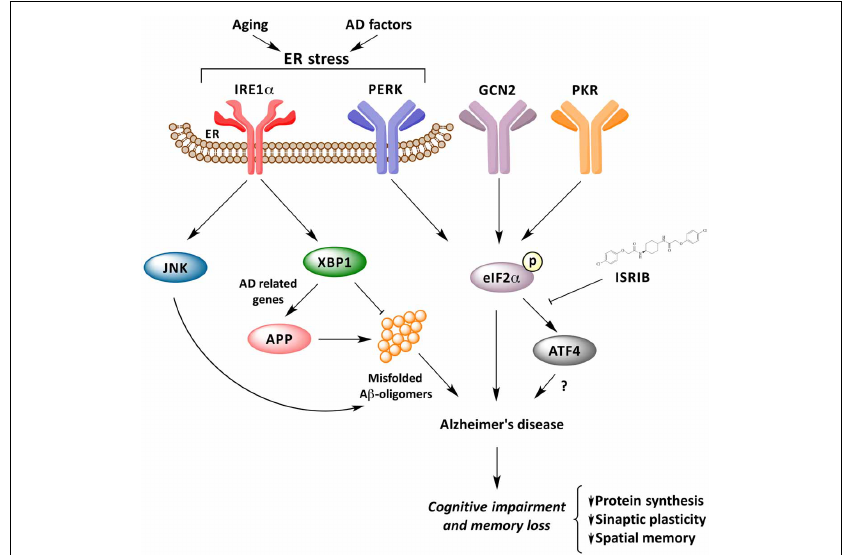
FIGURE 1 | UPR response underling memory consolidation in Alzheimer’s disease. Activation of ER stress signaling by abnormal protein misfolding activates several stress kinases leading to phosphorylation of eIF2 α , inhibiting protein synthesis. Phosphorylation of eIF2 α impairs synaptic function and cognitive processes. The IRE1 α /JKN pathway may feed forward to enhance amyloid deposition and AD process, whereas XBP1 has neuroprotective effects against A β toxicity, and controls the expression of a cluster of AD-related genes.